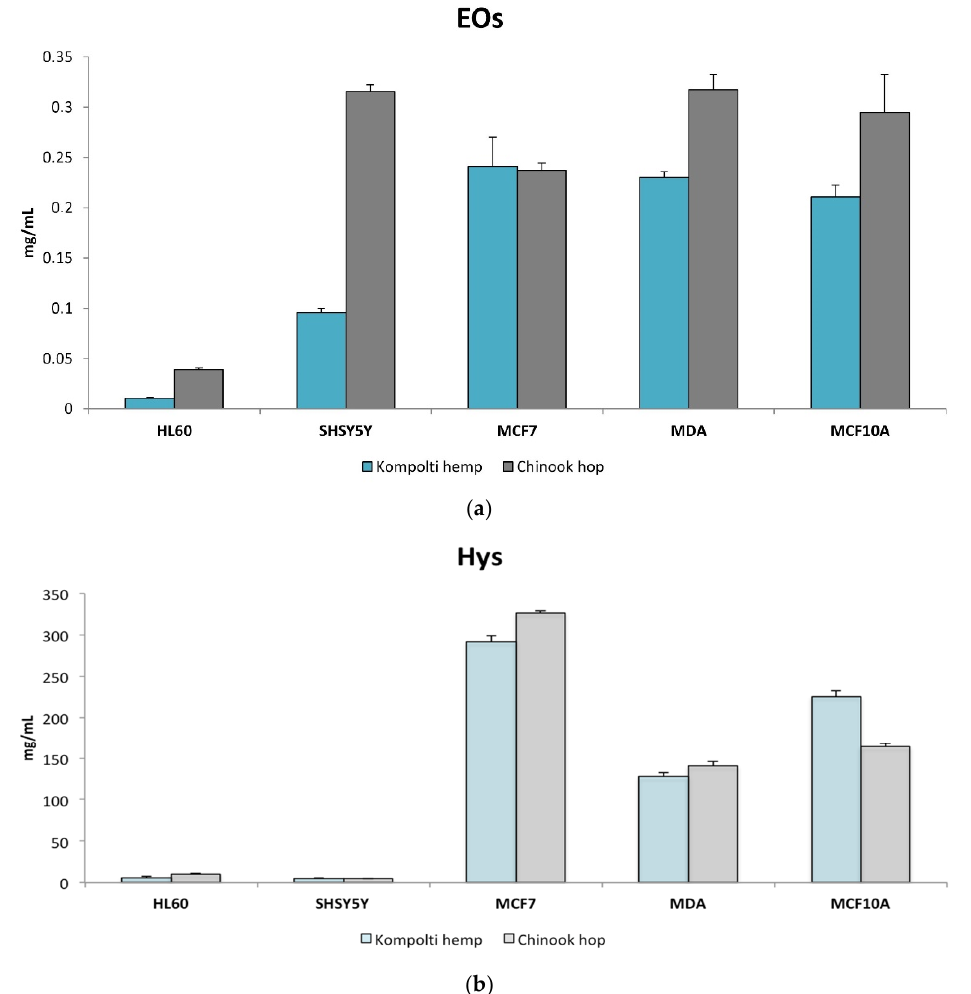
Figure 3. The EC 50 values of EOs ( a ) and Hys ( b ) from Kompolti hemp and Chinook hop. The values are expressed as mg/mL ± standard error mean (sem).